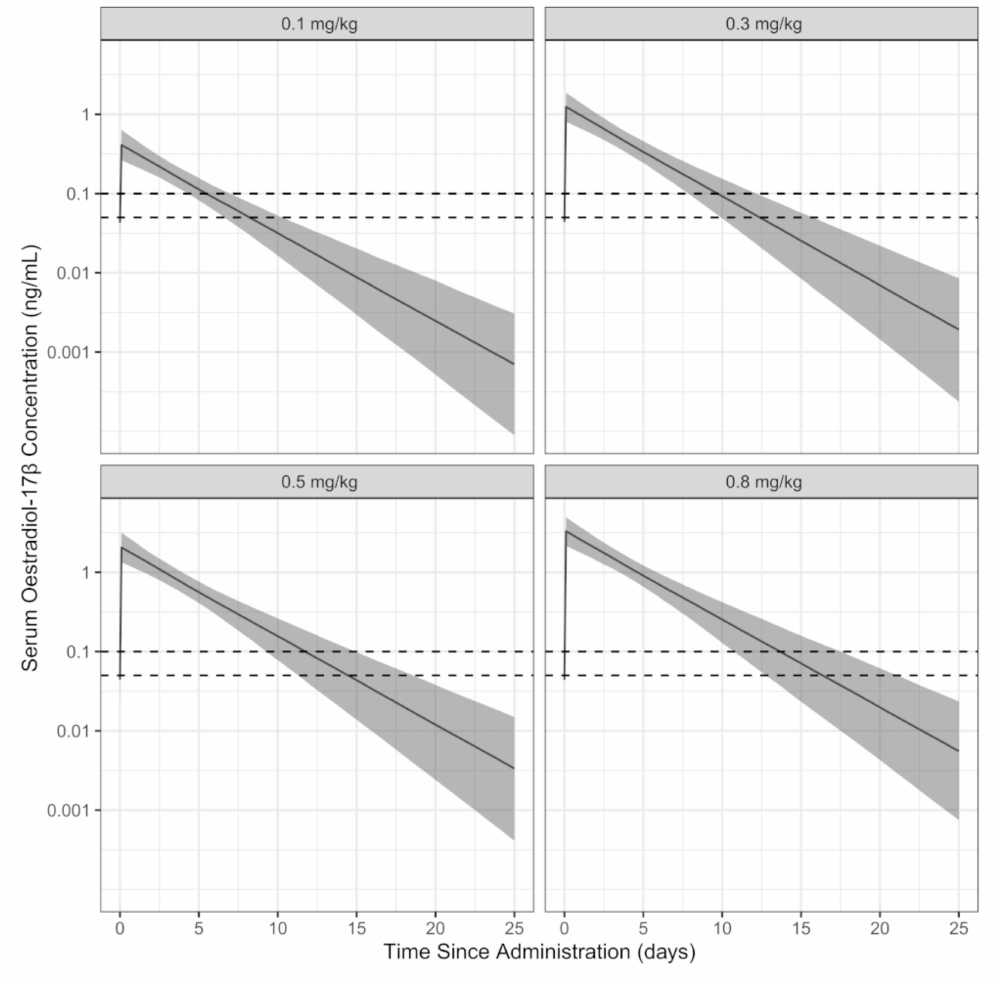
Figure 4. Predicted time-course of estradiol-17 β concentrations after simulated administration of 0.1, 0.3, 0.5, or 0.8 mg / kg intramuscular estradiol cypionate from the final pharmaco-statistical model. Each dose comprises 2000 simulated subjects. The dark solid line is the median concentration. The band represents, from top-down, the 90th and 10th percentile concentrations. The dashed lines represent 0.1 (upper) and 0.05 (lower) ng / mL of estradiol-17 β